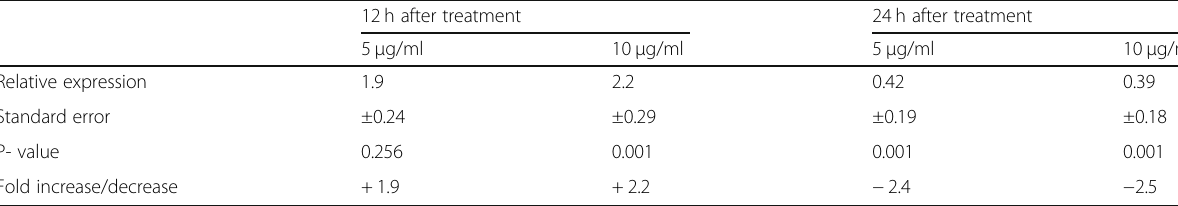
Table 5 The total expression ratio of the gene of bFGF in the MEFs treated with various concentration of ethanol extract of Calendula (5 and 10 μ g/ml) relative to control group is presented in each time (12 and 24 h after treatment). The statistic test for significance is randomization re-allocation test, implemented in the relative expression software tool. Significant down or upregulations of the genes